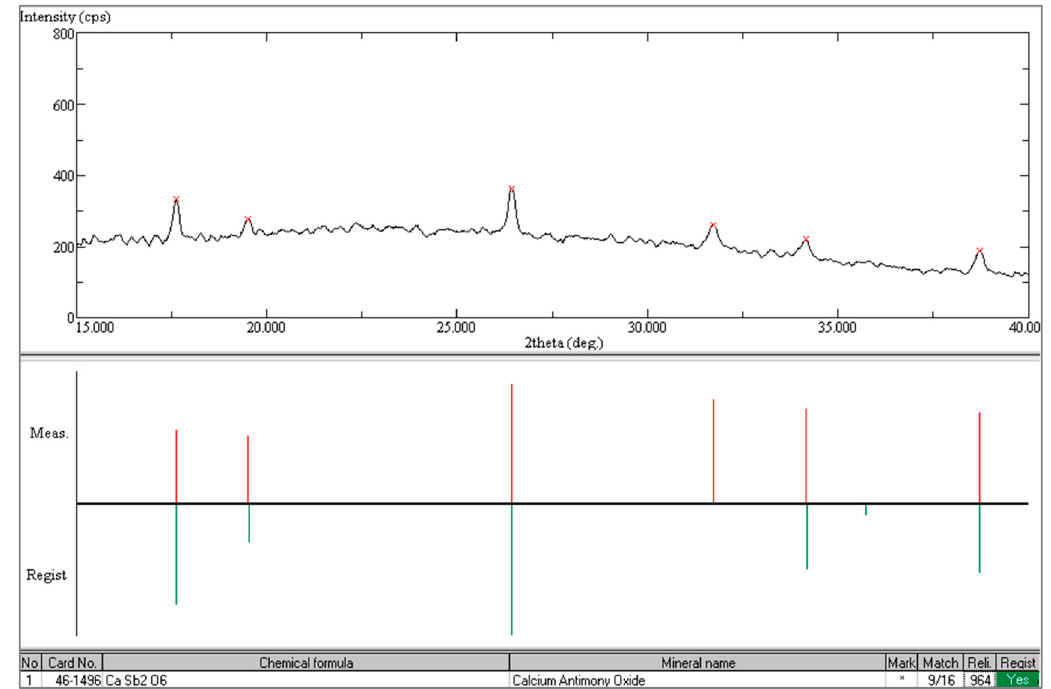
Figure 7. X-ray diffraction pattern showing the presence of hexagonal CaSb 2 O 6 in the glass (SSV_B1 blue sample from the monastery of San Severo in Classe, Ravenna, Italy—unpublished data).